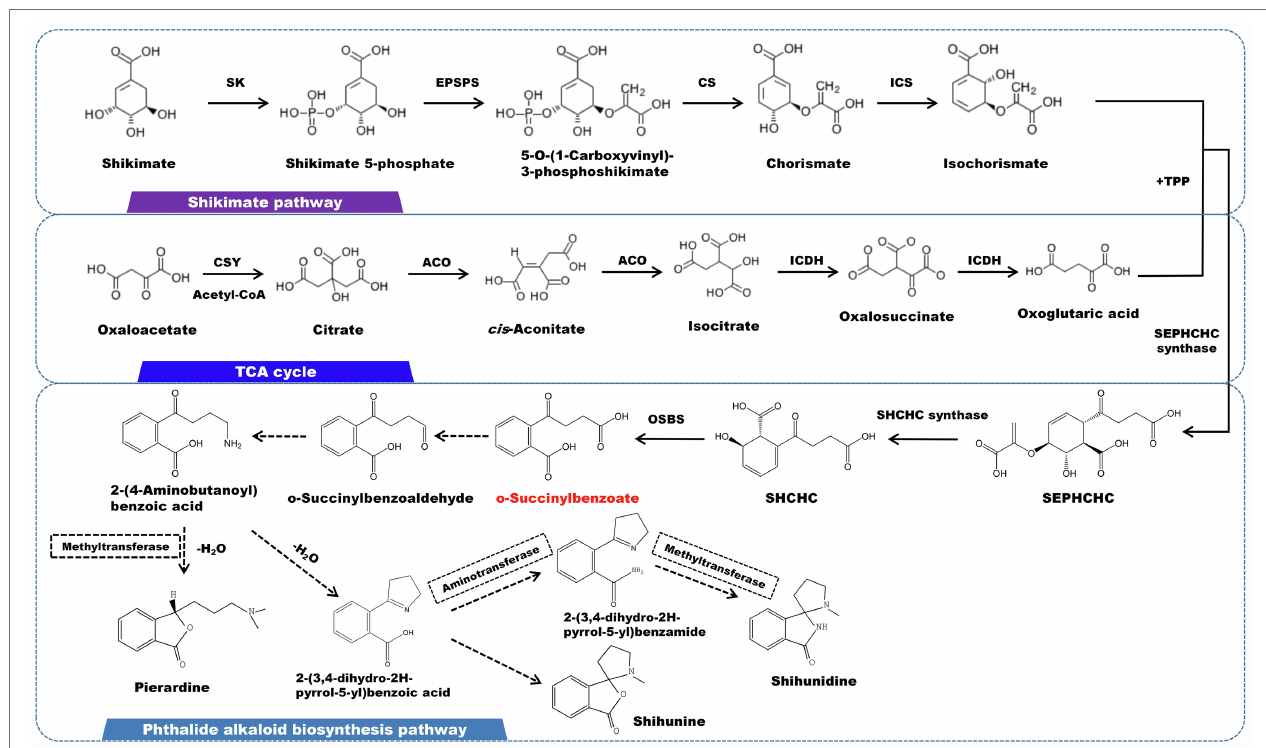
FIGURE 6 | A plausible biosynthesis pathway of phthalide alkaloids. The dashed box represents the putative enzymes. The dashed arrow represents the speculated pathway. Shikimate kinase (SK), 5-enolpyruvylshikimate 3-phosphate synthase (EPSPS), chorismate synthase (CS), isochorismate synthase (ICS), citrate synthase (CSY), aconitate hydratase (ACO), isocitrate dehydrogenase (ICDH) ， 2-succinyl-5-enolpyruvyl-6-hydroxy-3-cyclohexene-1-carboxylic acid synthase (SEPHCHC synthase), 2-succinyl-6-hydroxy-2,4-cyclohexadiene-1-carboxylate synthase (SHCHC synthase), o-succinylbenzoate synthase (OSBS). O-succinylbenzoate served as the core structure for the biosynthesis of the phthalide alkaloid, which is produced via the catalysis of